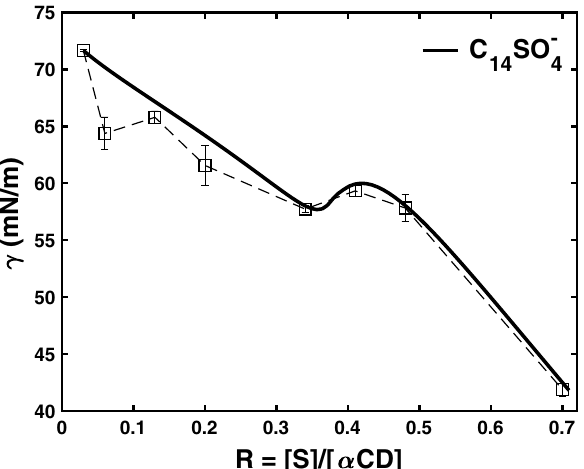
Figure 2. Surface tension of Eq. (3) as function of the ratio R for the anionic surfactant at 283.15K (solid line). Square points are experimental values from Ref. 12 for the mixture x mM C 14 SO − 4 (S) + 10 mM α -cyclodextrin x / 10 at 283.15 K. The dashed line is only to aid visualization. Water ( α -CD) + water, with R = [ S ] / [ α -CD] = surface tension γ 0 was taken as 72 mN/m. The value of η (55 mN m 2 /mol) was fitted as to match the highest 21.9 Å and 13.96 D, ζ 6 , h R experimental surface tension value. The other parameters where: µ e = = = d 14.6 Å 11 =